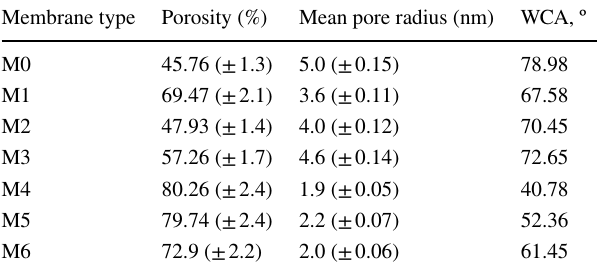
Table 2 The porosity, mean pore radius, and water contact angle of the fabricated nanofiltration membranes Membrane type